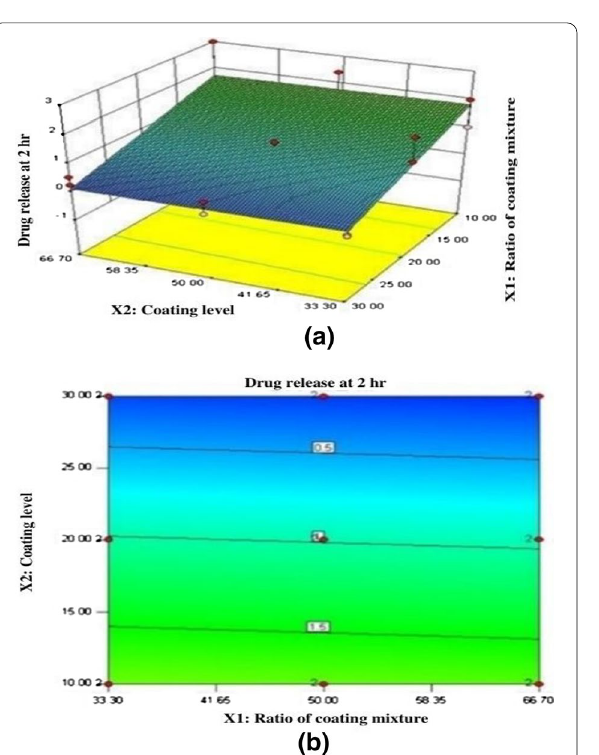
Fig. 4 Response surface method analysis for (Table 2) Y 1 [ a response surface plot & b response contour plot]